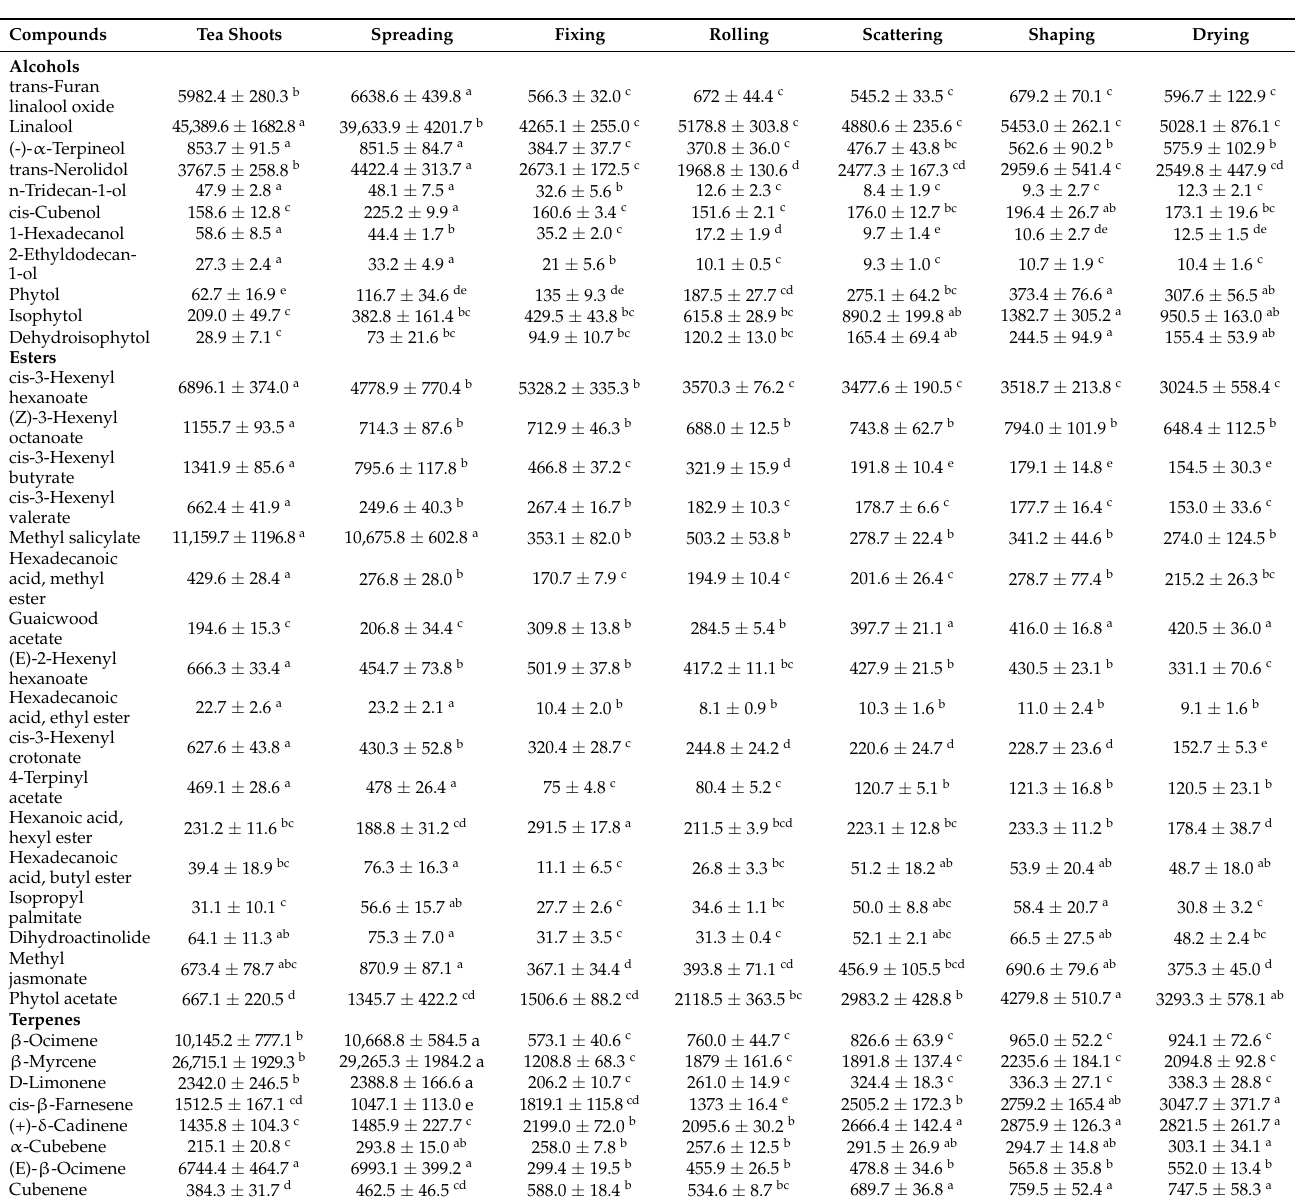
Table 1. Changes in the concentrations of volatile compounds during the XYMJ green tea manufac- turing ( µ